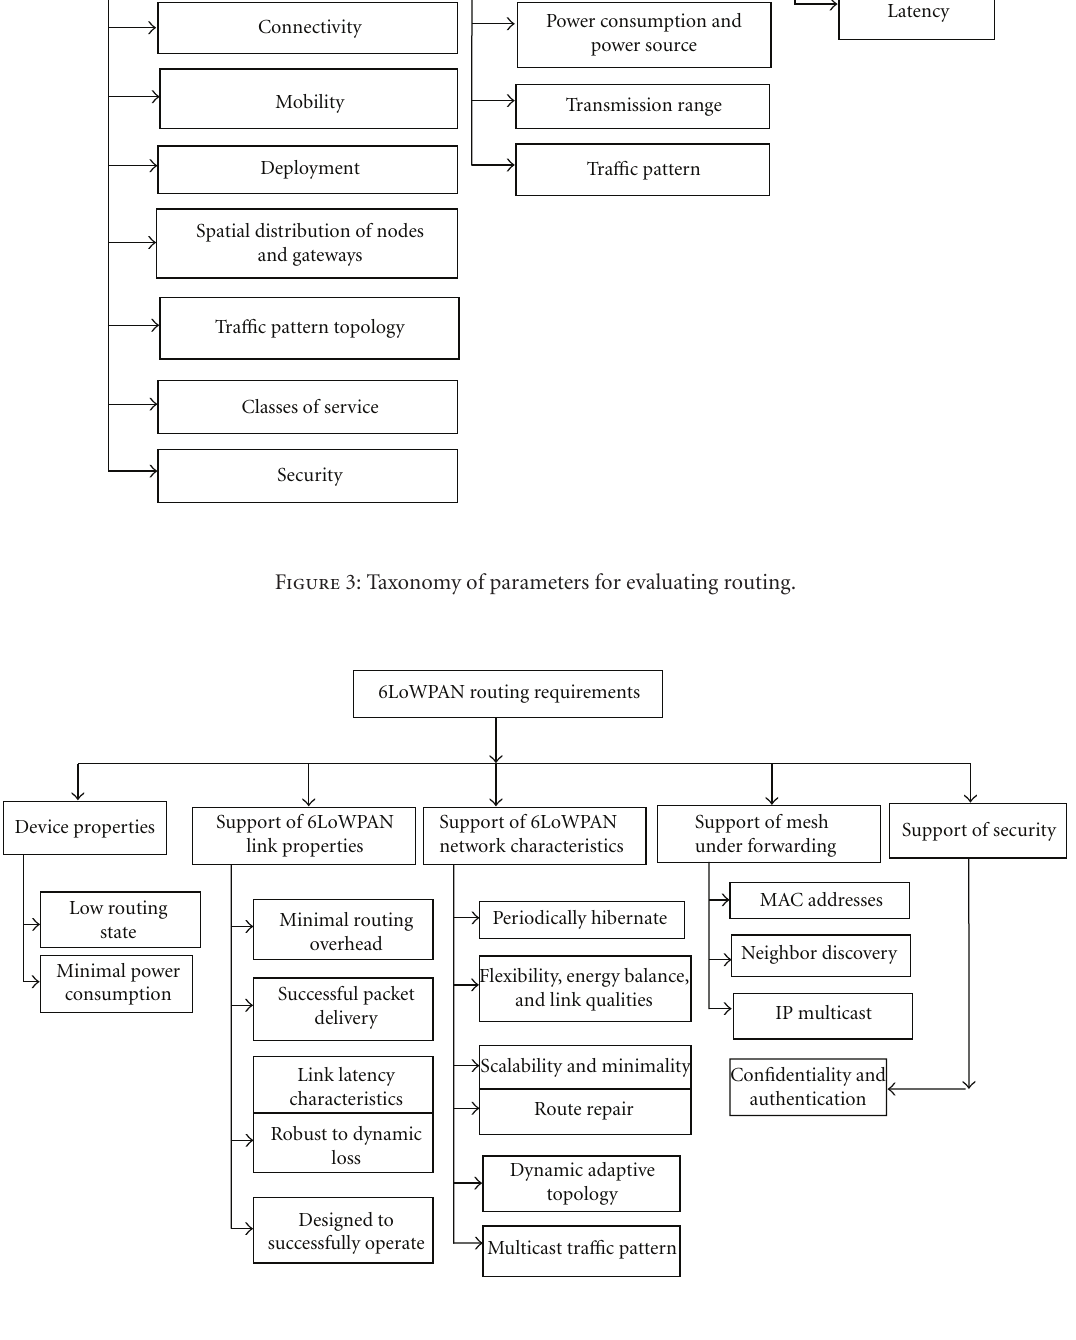
Figure 4: Taxonomy of routing requirement in